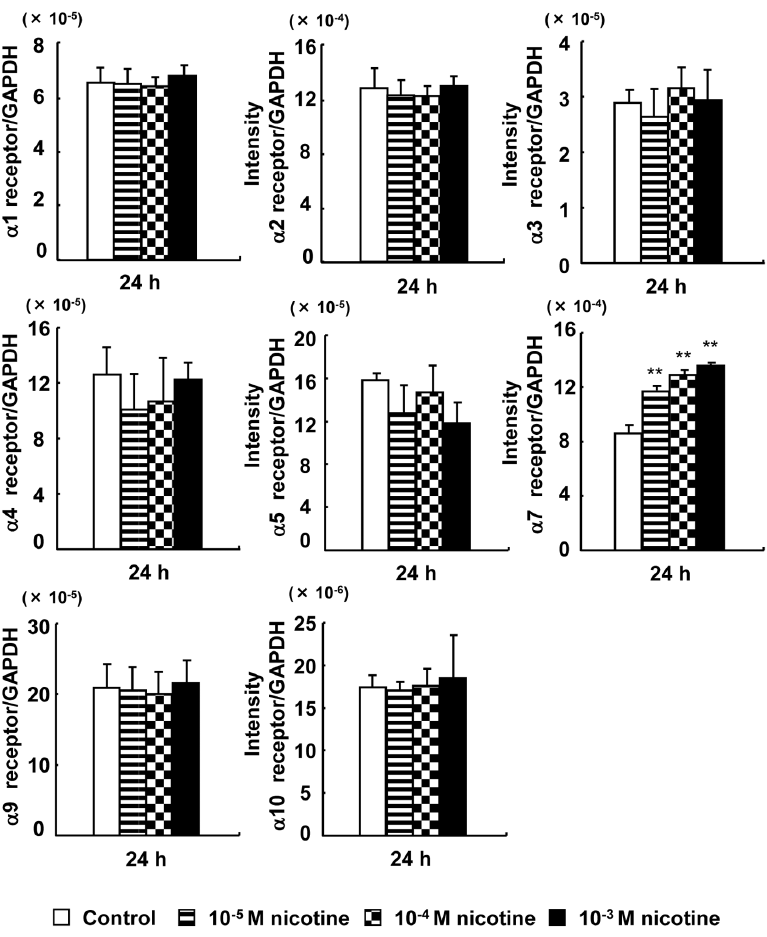
Figure 1. Effect of nicotine on the mRNA expression of nicotine receptors. RAW264.7 cells were cultured in differentiation medium with 0 (control), 10 2 5 , 10 2 4 , or 10 2 3 M nicotine for 24 h, and the expression of nicotine receptors ( a 1–7, a 9, and a 10) at the mRNA level was determined with real-time PCR. Data are expressed as the mean 6 standard deviation (S.D.), n=3 independent experiments. *p , 0.05, **p , 0.01, nicotine treatment vs. control.